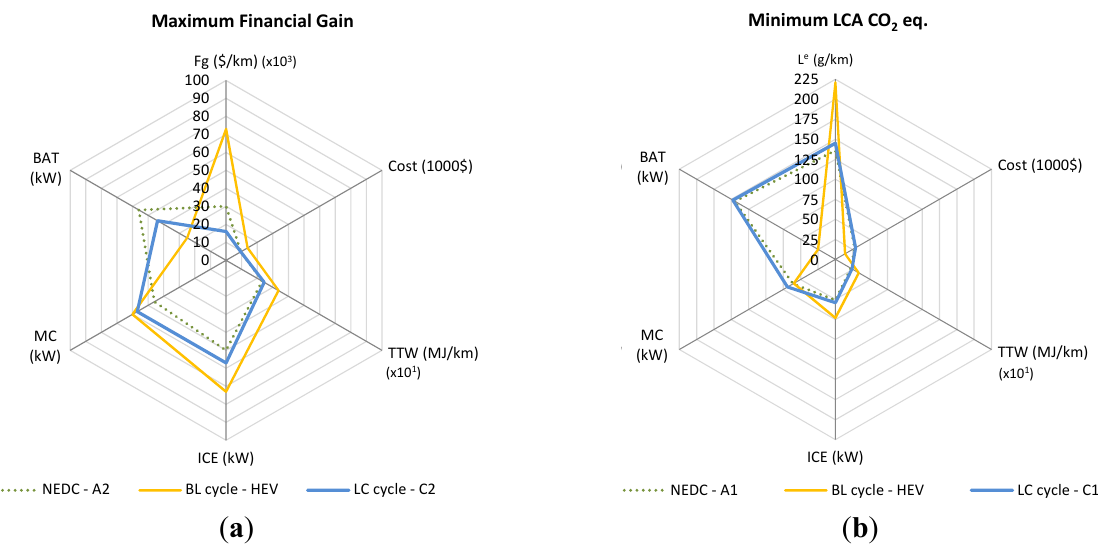
Figure 7. Main components nominal power, vehicle cost, and fuel consumption, of for the “best” vehicles for each driving cycle (NEDC, BL-urban, LC extra-urban) concerning ( a ) maximum financial gain and ( b ) minimum LCA CO 2eq